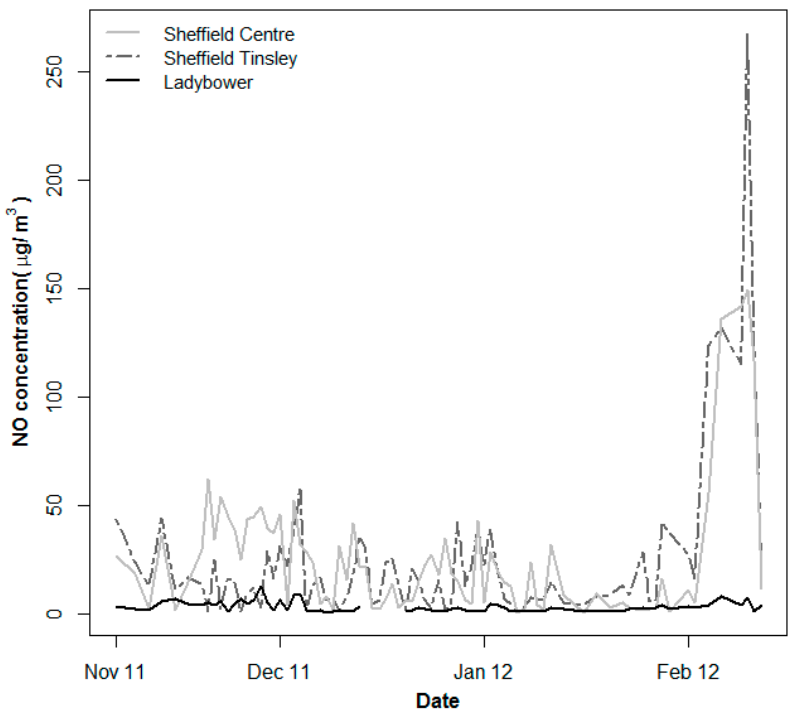
Figure 2. Distribution of RSV infected cases admitted to Sheffield Children’s Hospital and location of monitoring stations.